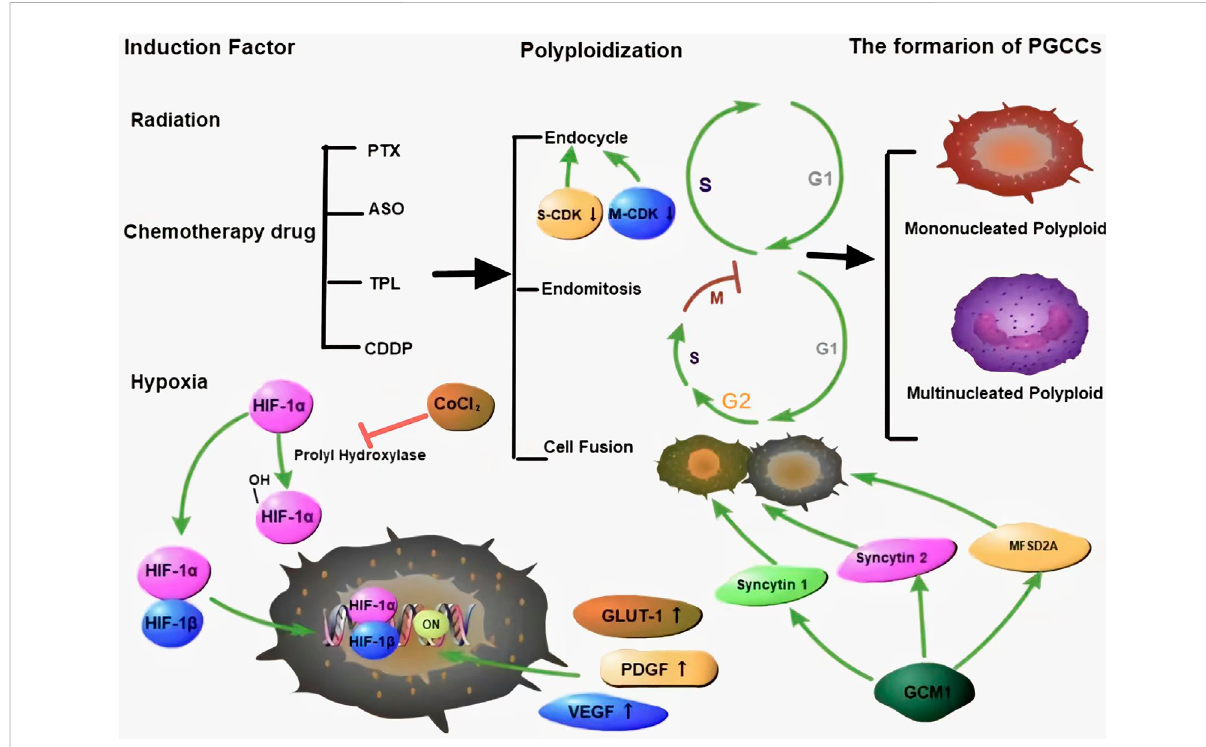
FIGURE 1 Many kinds ofstressescan induce theformation of PGCCs, whichcan occur via endoreplication and cell fusion. There are two kinds of PGCCs, multinucleatedandmononucleatedgiantcancercells.HIF-1 α isakeyproteinthatisregulatedbyprolinehydroxylaseandisassociatedwiththeCSC- related characteristics of PGCCs. Green arrows represent potentiation, while red lines represent inhibitive